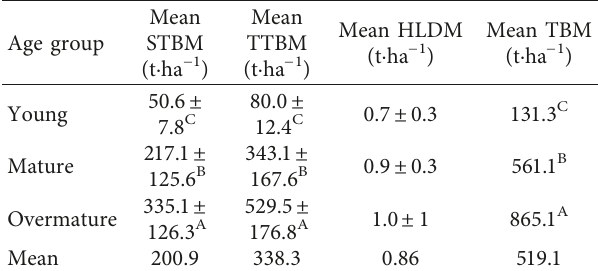
Table 4: Biomass of Chir Pine